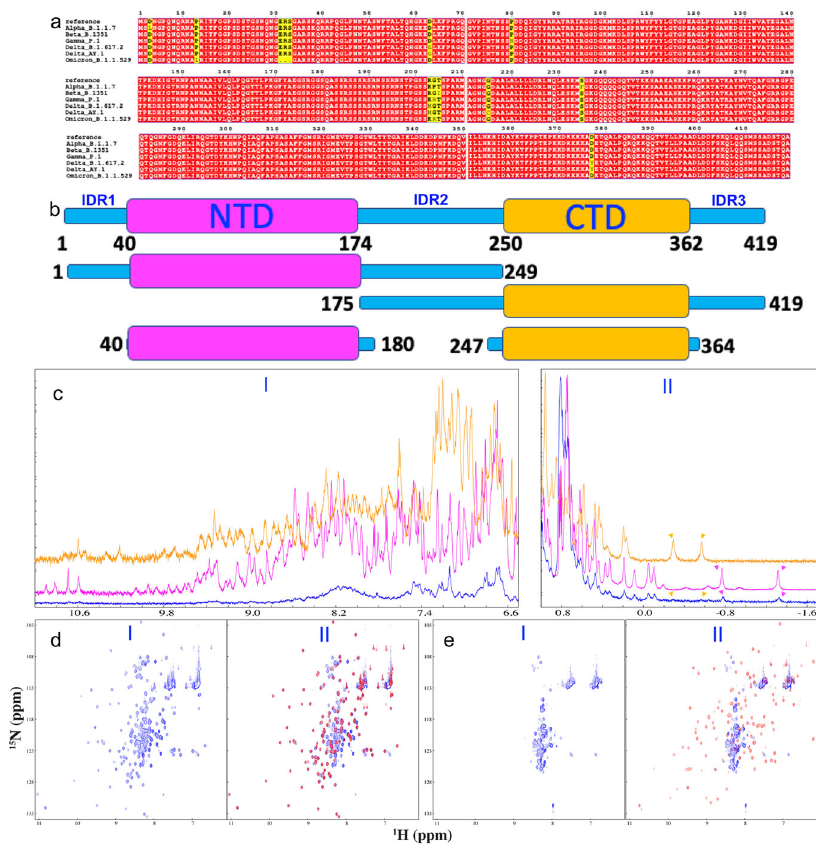
Fig. 1 NMR characterization of differentially-dissected domains of SARS-CoV-2 N protein. a Sequence alignment of N protein of Variants of Concern (VOCs) of SARS-CoV-2 according to WHO: https://www.who.int/en/activities/tracking-SARS-CoV-2-variants. b Differentially-dissected domains of SARS-CoV-2 N protein used in this study. c One dimensional NMR proton spectra of the full-length N protein (blue), NTD (purple) and CTD (light brown) for the amide proton (I) and side-chain (II) regions. Arrows are used to indicate very up- fi eld signature NMR signals of methyl groups of NTD (purple) and CTD (light brown) in 1D NMR spectra. d HSQC spectrum of N (1-249) (I) and superimposition of HSQC spectra of N(1-249) (blue) and NTD (40-180) (red) (II). e HSQC spectrum of N (175-419) (I) and superimposition of HSQC spectra of N (175-419) (blue) and CTD (247-364) (red)